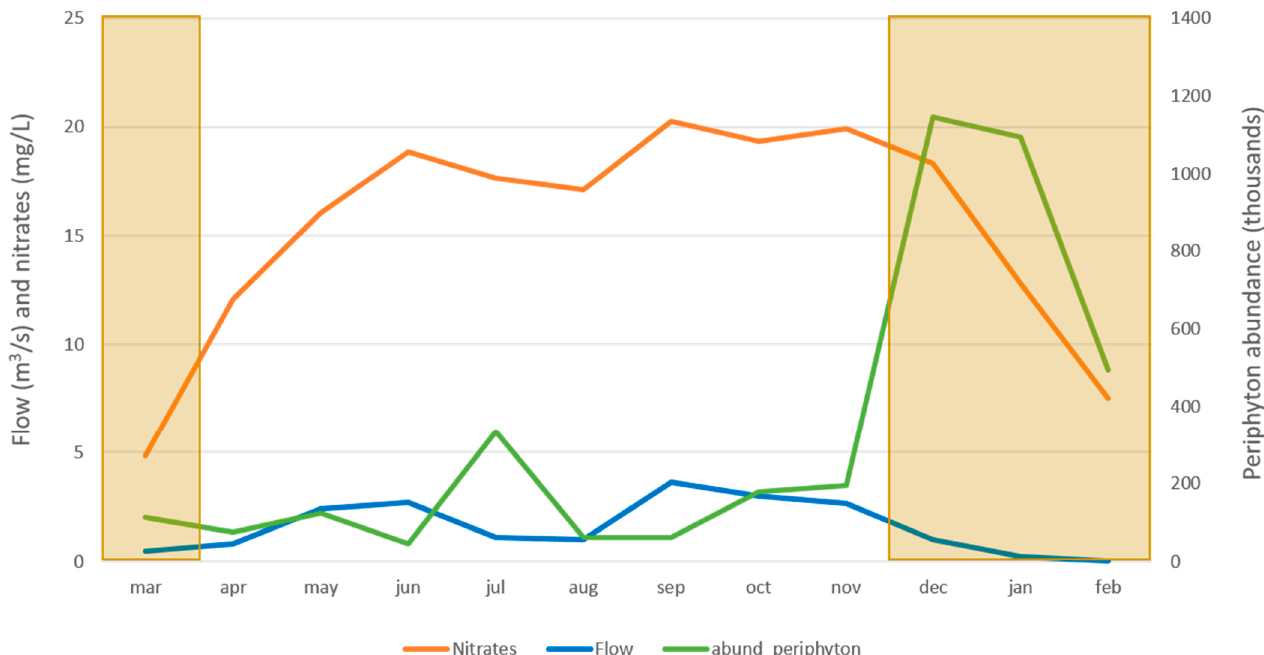
Figure 1. Temporal variations of the flow (m 3 /s), nitrate (mg/L), and phytoperiphyton abundance (thousands), measured in the 2018–2019 sampling period in the Peje stream. Darker boxes represent dry season periods.